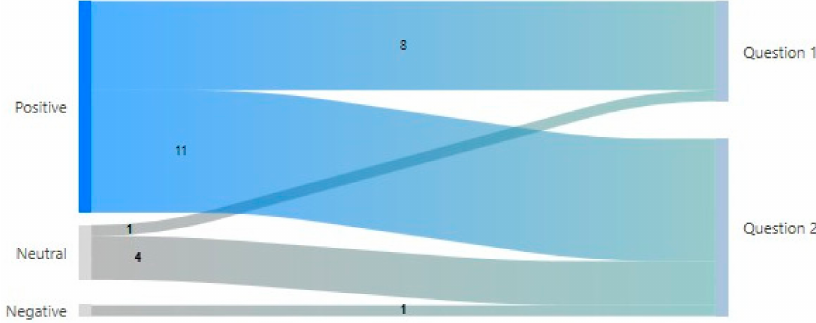
Figure 10. Sentimental analysis of answers to questions 1 and 2 in the QSOQT